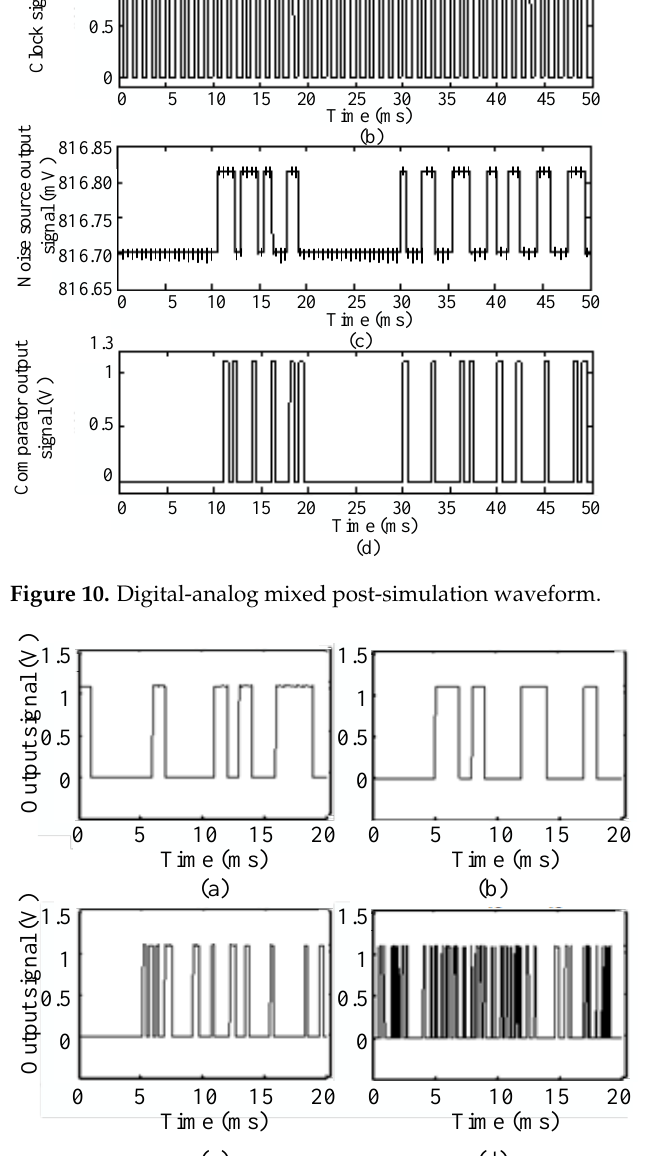
Table 1. National Institute of Standards and Technology (NIST) randomness testing results.